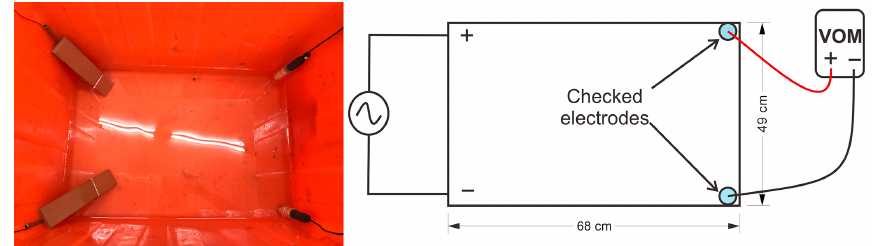
Figure 7. The layout for the evaluation of the electric receivers. Two copper electrodes are used to vary the input signals. A pair of silver chloride electrodes are placed at the corner of a tank with an area of 68cm × 49cm filled with 15cm of seawater. A VOM is used to measure the self-potential and impedance of the electrodes.